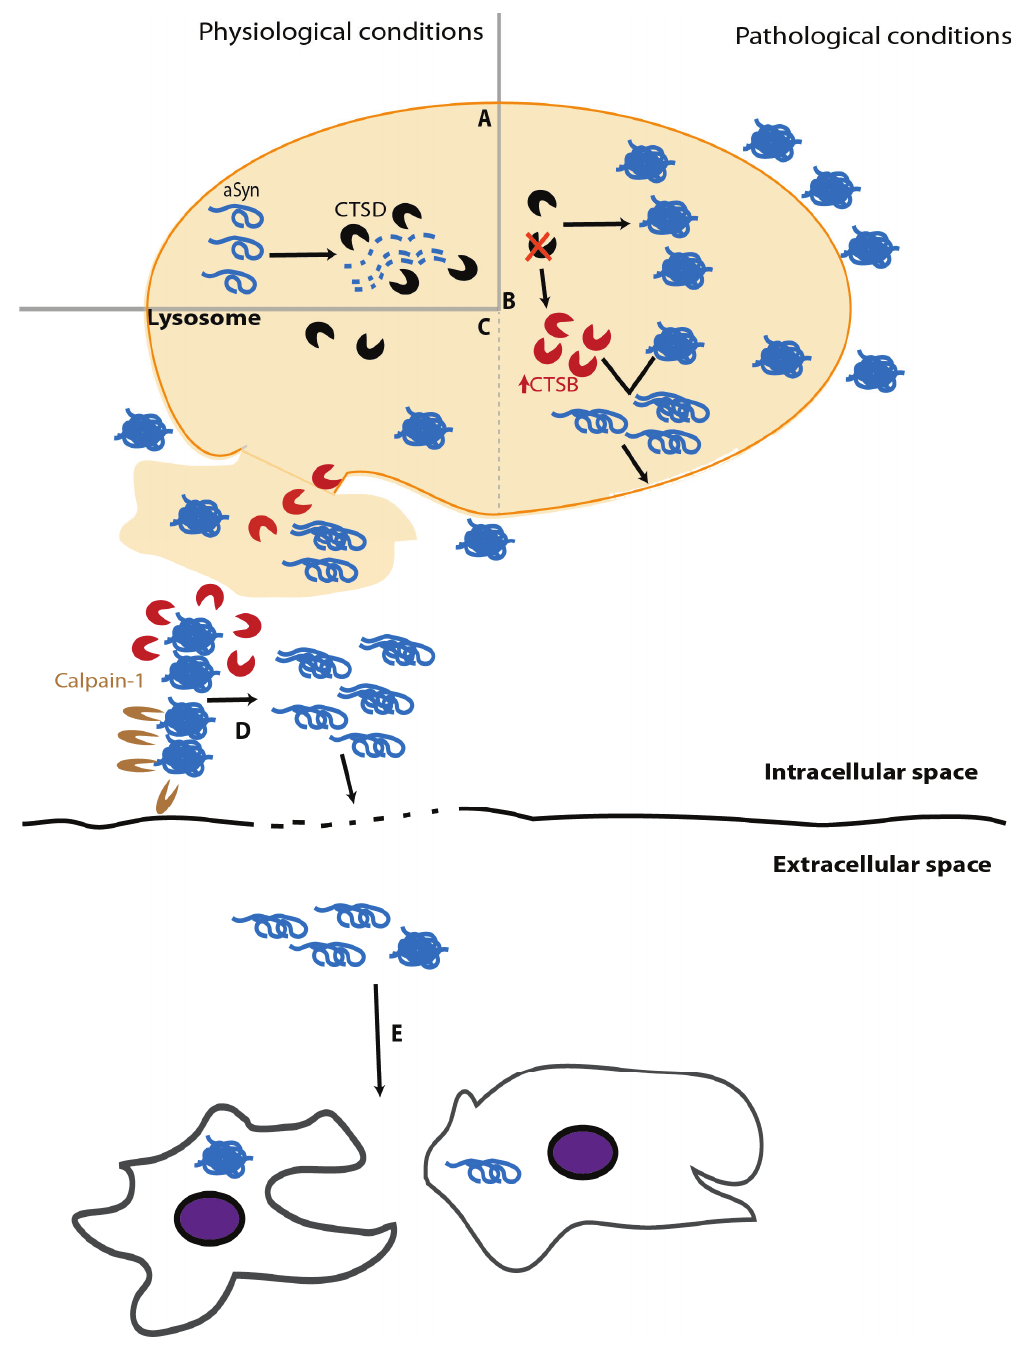
Figure 3. Lysosomal dysfunction can promote the release of miscleaved aggregation-prone (cid:2)-syn species. ( A ) Under physiological conditions, CTSD is the main lysosomal enzyme clearing (cid:2)-syn. ( B ) Deficient CTSD function promotes (cid:2)-syn aggregation and lysosomal dysregulation, including the up-regulation of other enzymes such as CTSB that can convert (cid:2)-syn aggregates into seeding particles able to break and escape from lysosome. ( C ) Lysosomal rupture releases the content of the organelle (e.g., lysosomal enzymes and toxic (cid:2)-syn species). ( D ) These protein particles can be targeted by Calpain1, whose activity, together with that of CTSB, also generates (cid:2)-syn propagating species. ( E ) (cid:2)-syn toxic species can be released to the extracellular space by unknown mechanisms or by cell death derived from lysosomal rupture and be internalized by surrounding